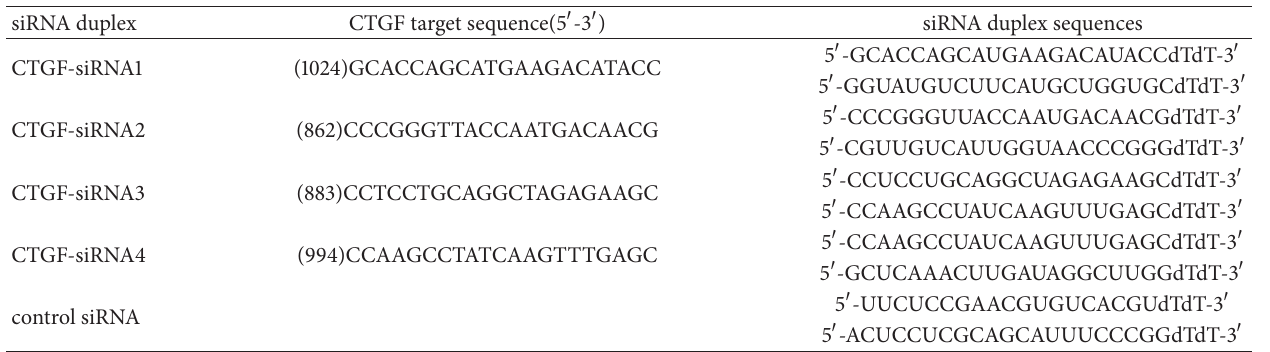
Table 1: Targets and duplex sequences for human CTGF specific siRNAs and control